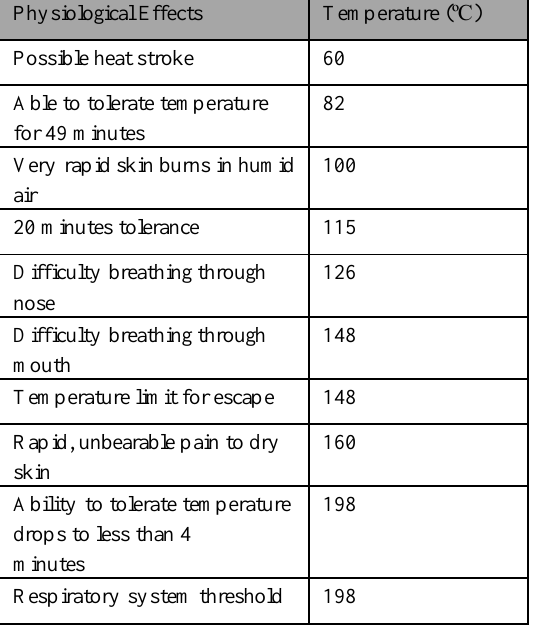
Table 1. Physiological effects of heat.